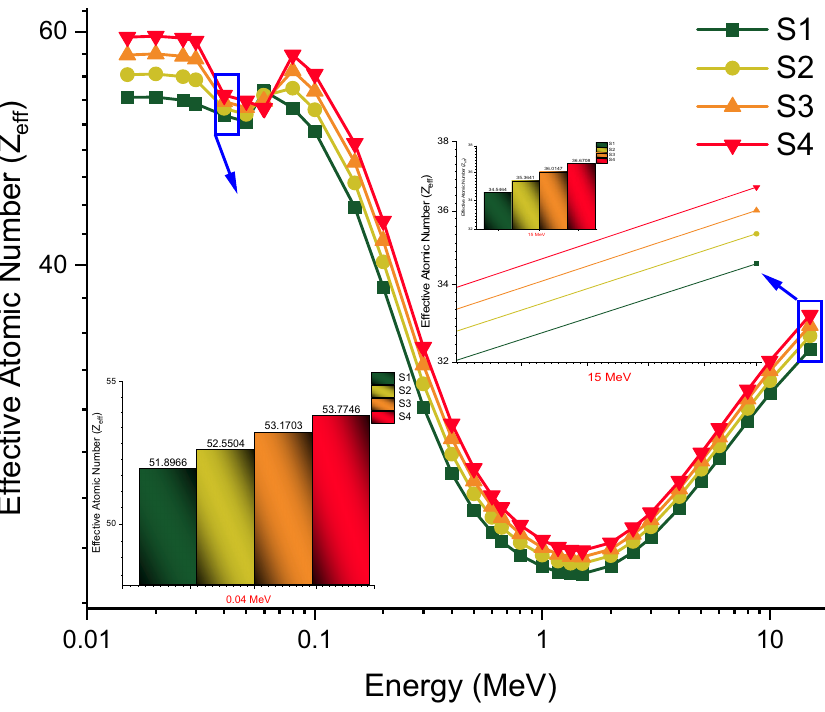
Figure 7: Variation in e ff ective atomic number ( Z e ff ) with photon energy ( MeV ) for all S1 – S4 glasses.